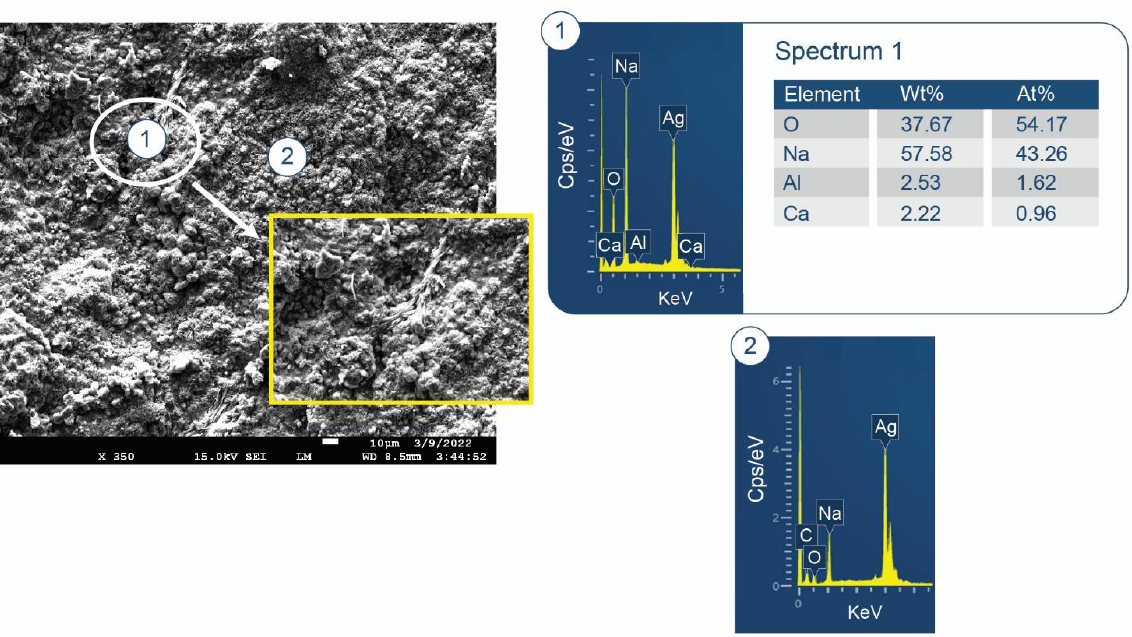
Figure 8. Morphology and elemental composition of freshly fractured neat CaP cement after curing at 100 °C.